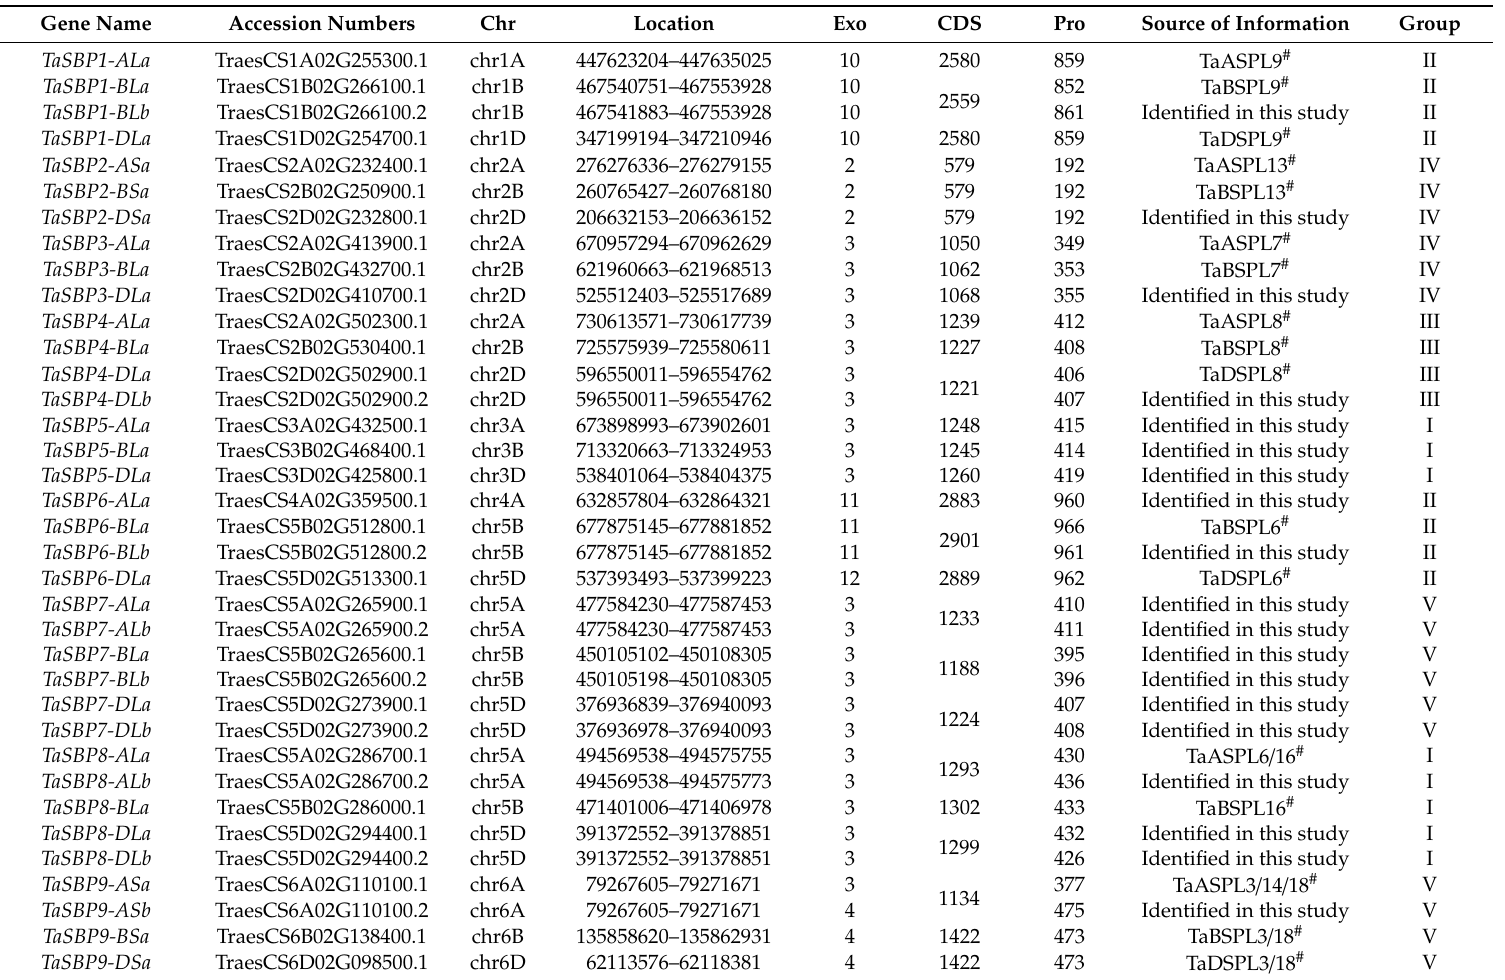
Table 1. Details of the SBP transcription factor family in hexaploid